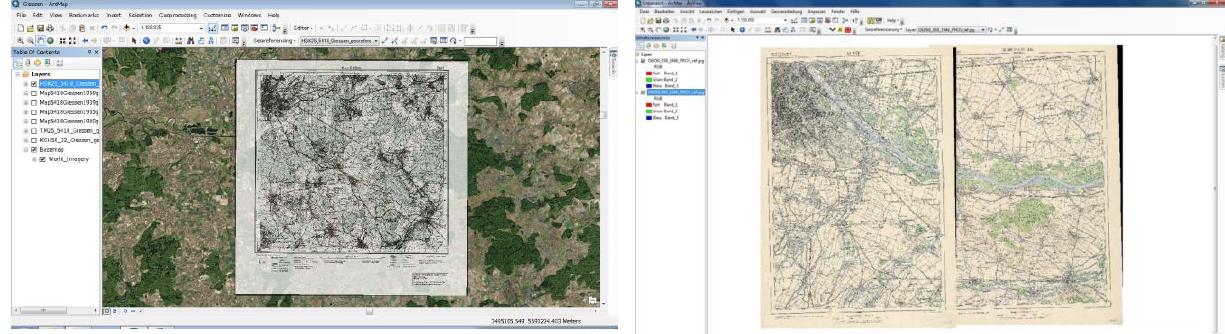
Figure 9. Ancient map, Giessen pronunciation in Germany